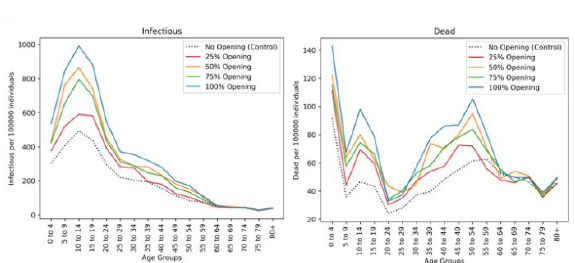
Figure 3. School Re-Opening Sensitivity Analysis